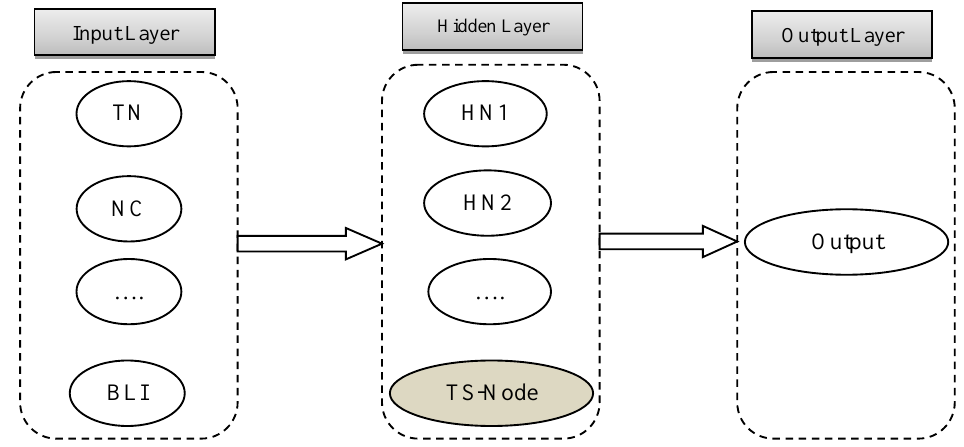
Figure 1. Schematic view of the new combined time-series and neural network model